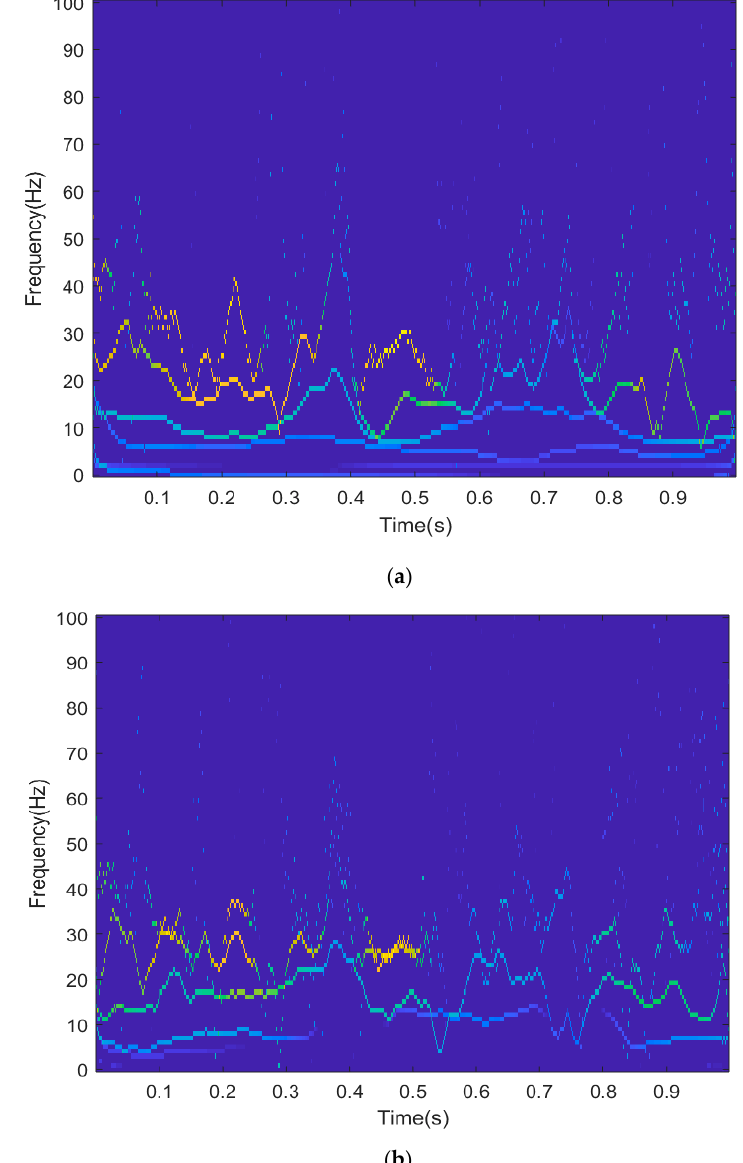
Figure 6. Time-frequency maps by EMD ( a ) and CEEMDAN ( b ) of the seismic signal (Figure 4).